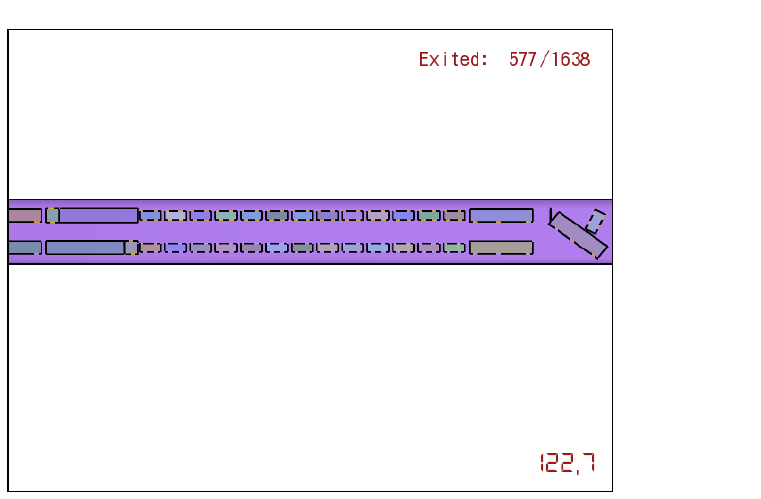
Figure 9 – The simulation example for the noted case after 122.7 seconds from the start of the simulation